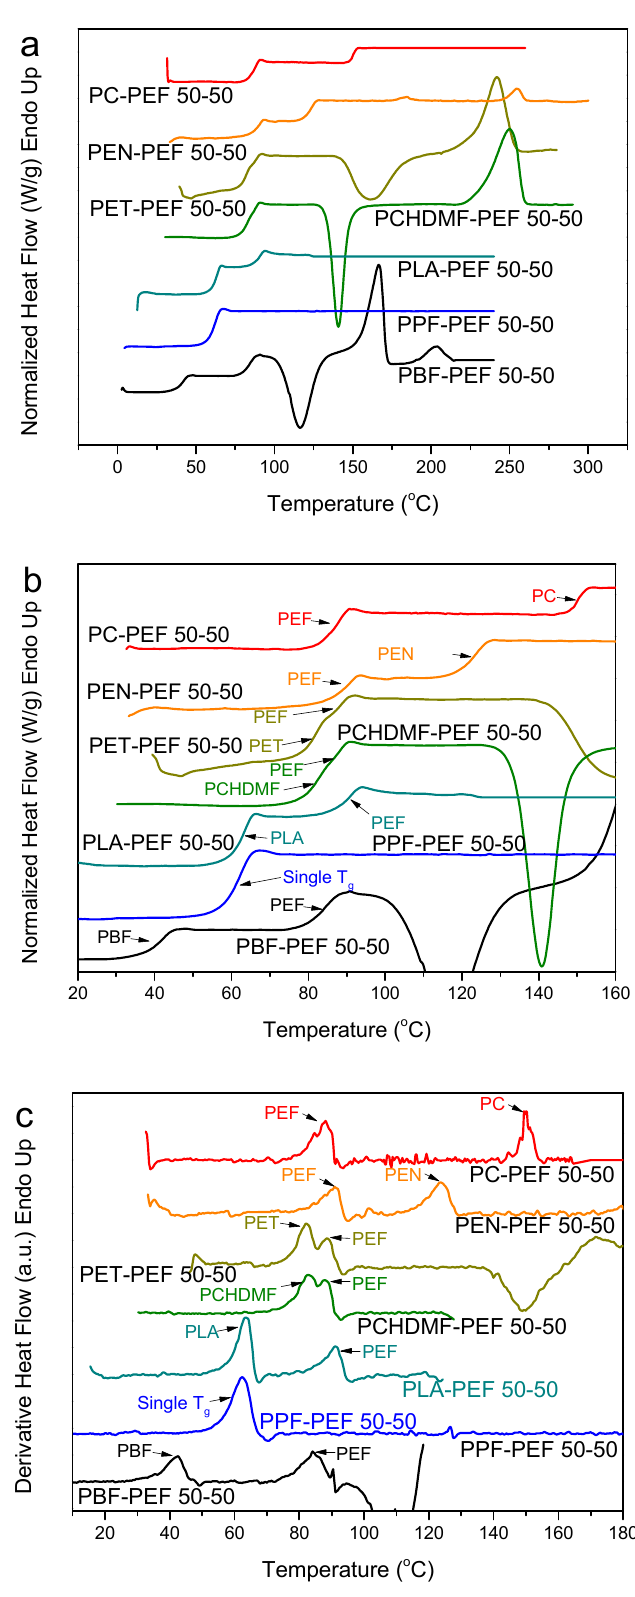
Figure 5. ( a ) DSC heating thermograms, ( b ) details of DSC thermograms in the T g region, and ( c ) derivative heat flow for melt-quenched PEF blend samples with various polymers and 50-50 composition.